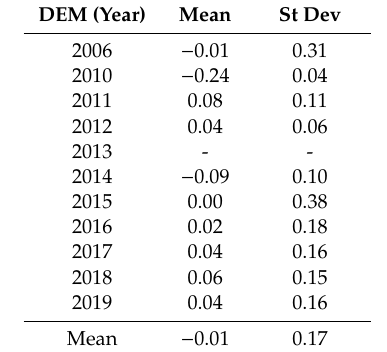
Table 5. Statistics of elevation di ff erences calculated among individual DEMs and the reference 2013 TLS DEM over stable area in proximity to the